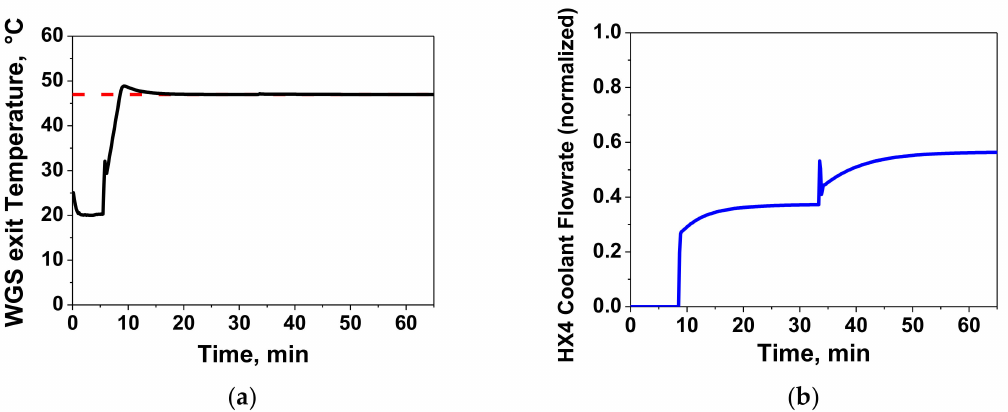
Figure 6. ( a ) Temperature profile of the WGS exit (TC3 controller) and ( b ) coolant flowrate manipulation at the HX4.